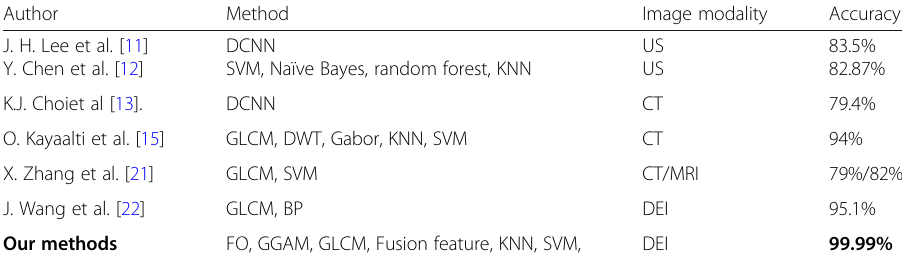
Table 5 Summary of similar study carried out on hepatic fibrosis